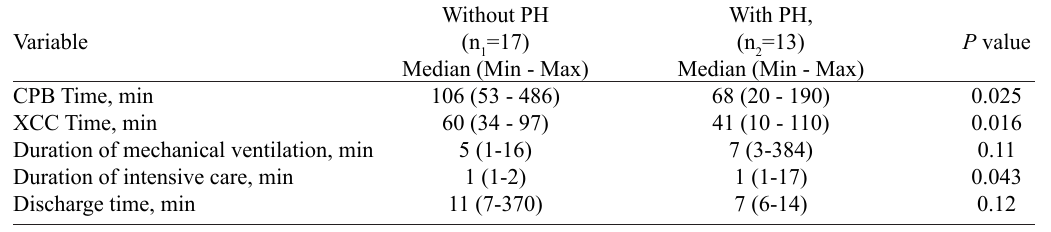
Table 2. Descriptive statistics of patients with and without